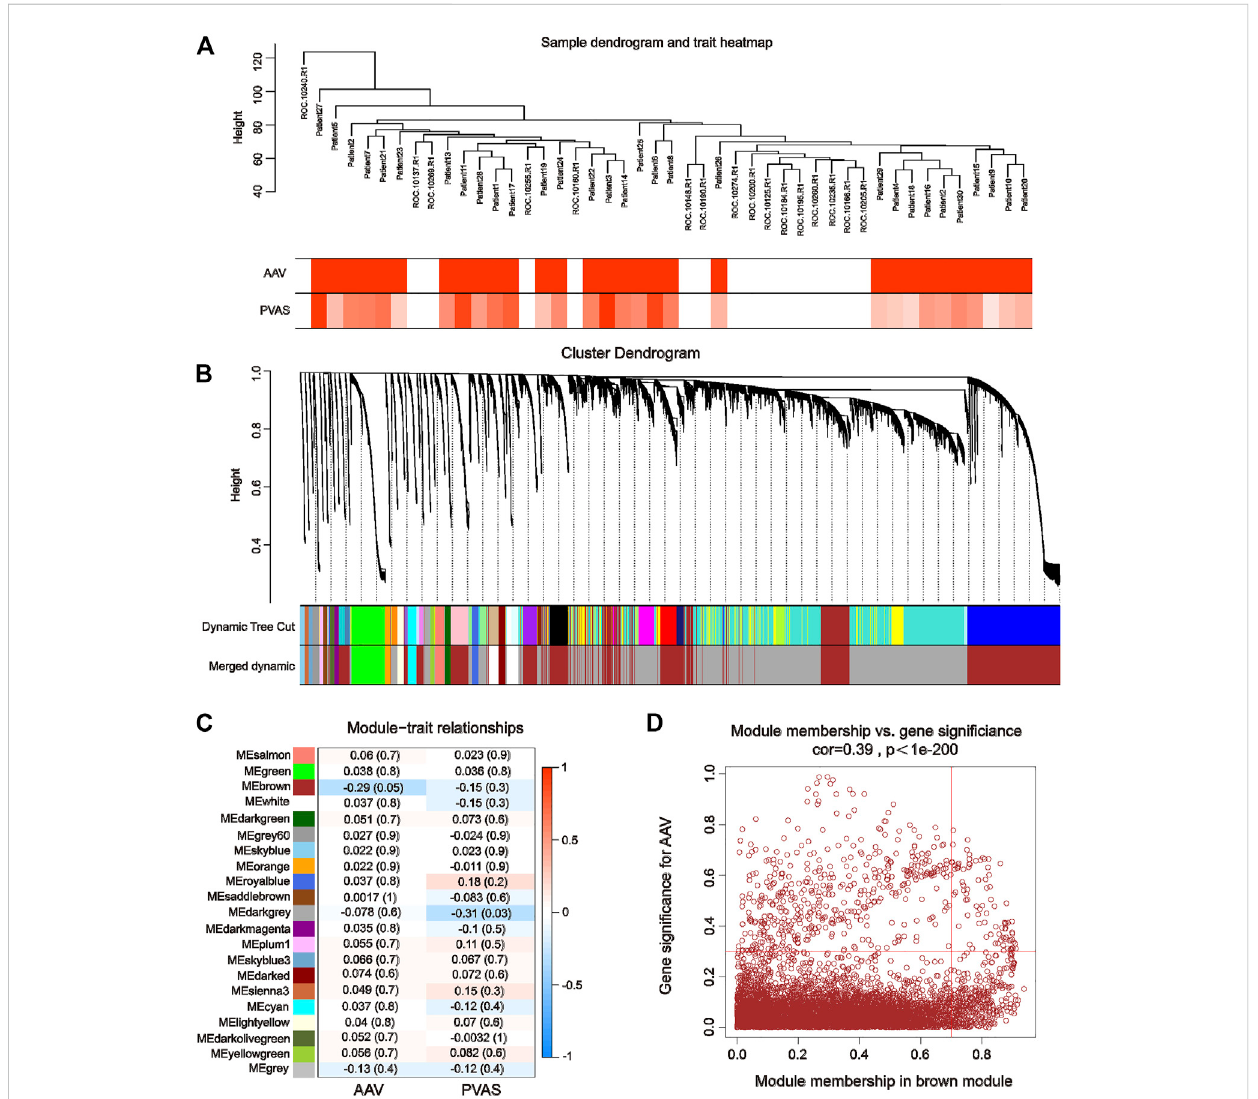
FIGURE 2 Weightedgeneco-expressionnetworkanalysisusingGSE129752andGSE111459. (A) Sample-traitclusteringheatmap. (B) Dynamicshearingtreemergingsimilar modulegenes. (C) Module-traitcorrelationheatmap. (D) Scatterplotforcorrelationbetweengenemodulemembershipinthebrownmoduleandgenesigni fi